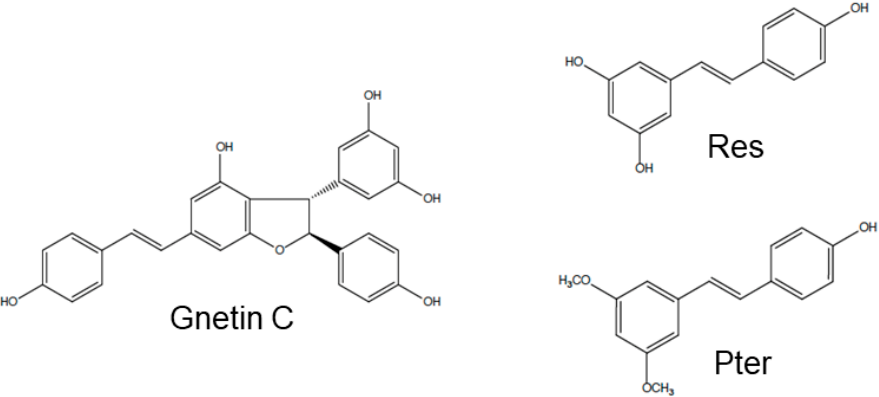
Figure 1. Chemical structures of Gnetin C (MW: 454.4 g/mol), Resveratrol (Res, MW: 228.3 g/mol), and Pterostilbene (Pter, MW: 256.3 g/mol).